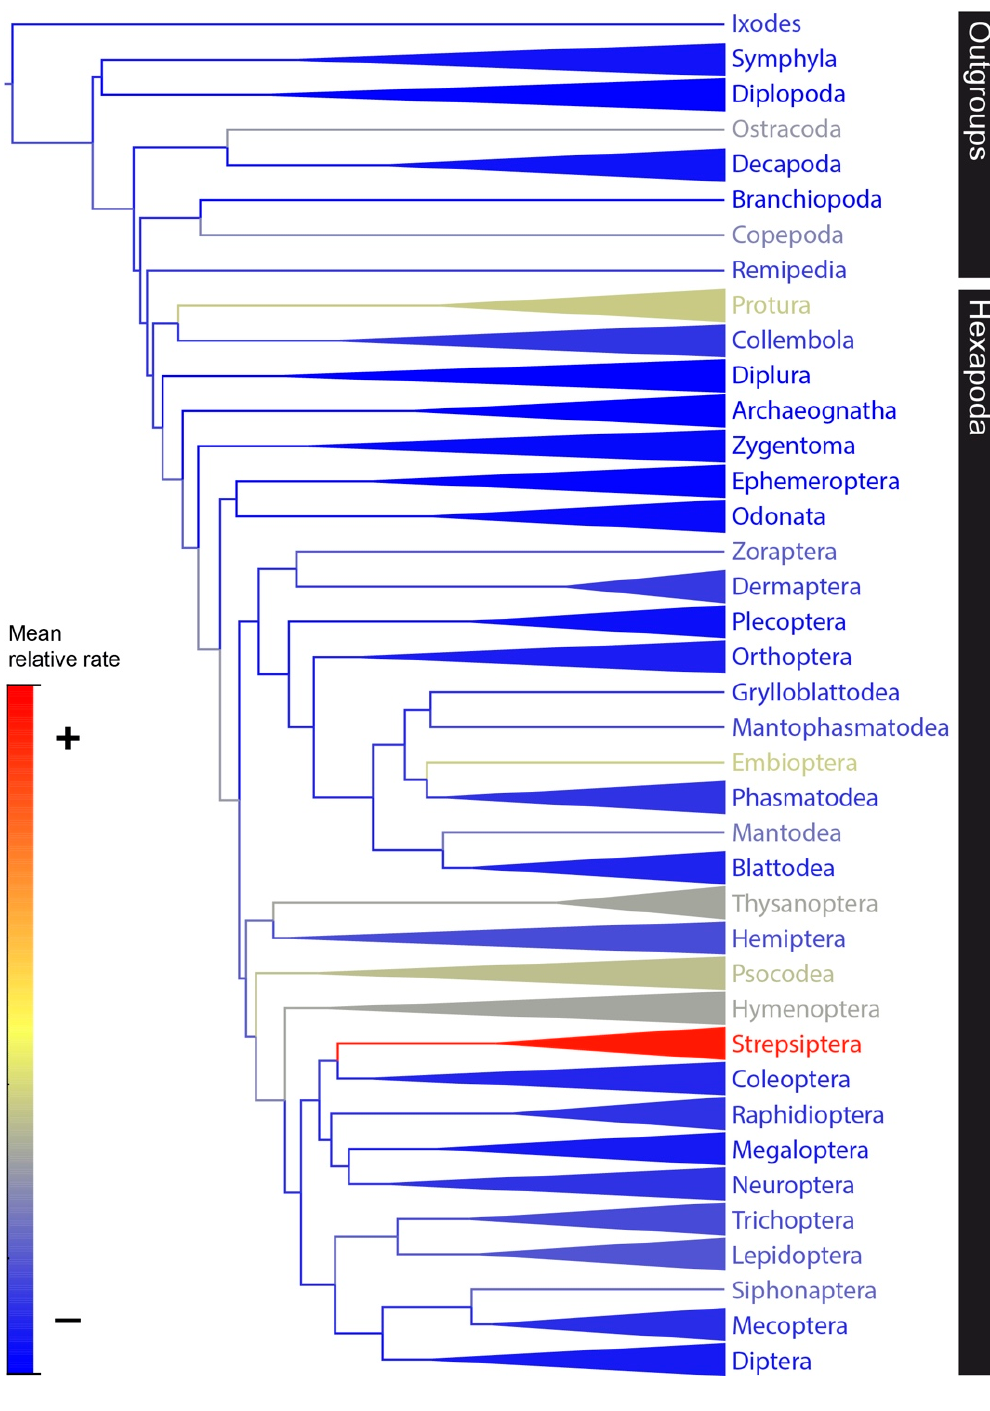
Figure 2. Bayesian COI gene tree using a topological constraint matching Misof et al . ’s [61] phylogeny and a relaxed molecular clock set to 1 substitutions/site/time to estimate relative rates of nucleotide substitution across Hexapoda. Branch/label colors indicate mean relative rates for each clade (see scale). Clades with multiple taxa are collapsed into cones. See Figure S2 for phylogeny displaying all branches with support values for non-constrained nodes.